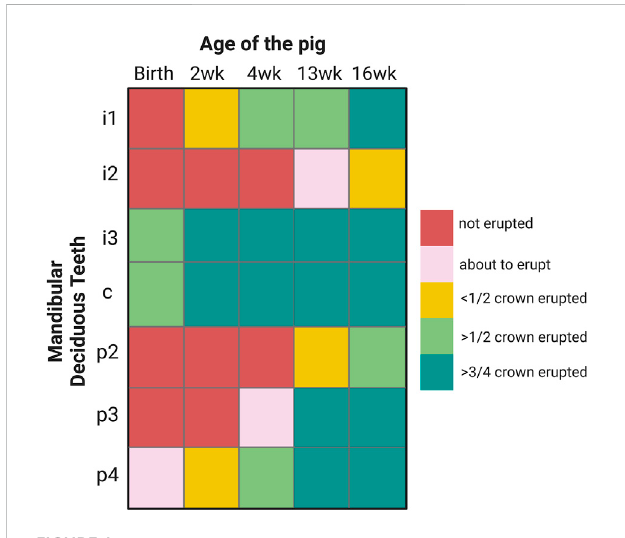
FIGURE 1 Eruption sequenceof2,4,13 and16-week-old pigsthat areusedin this study. I: incisor, c: canine, p: premolar.